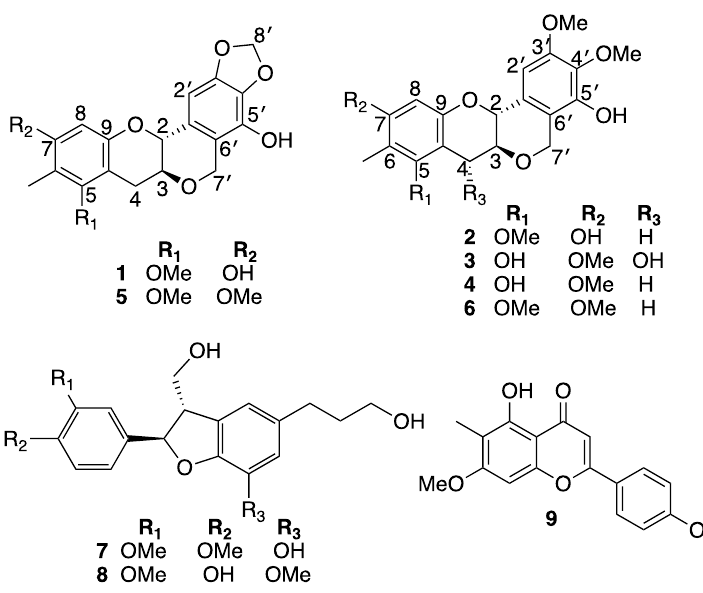
Figure 1. Structures of compounds 1 – 9 .